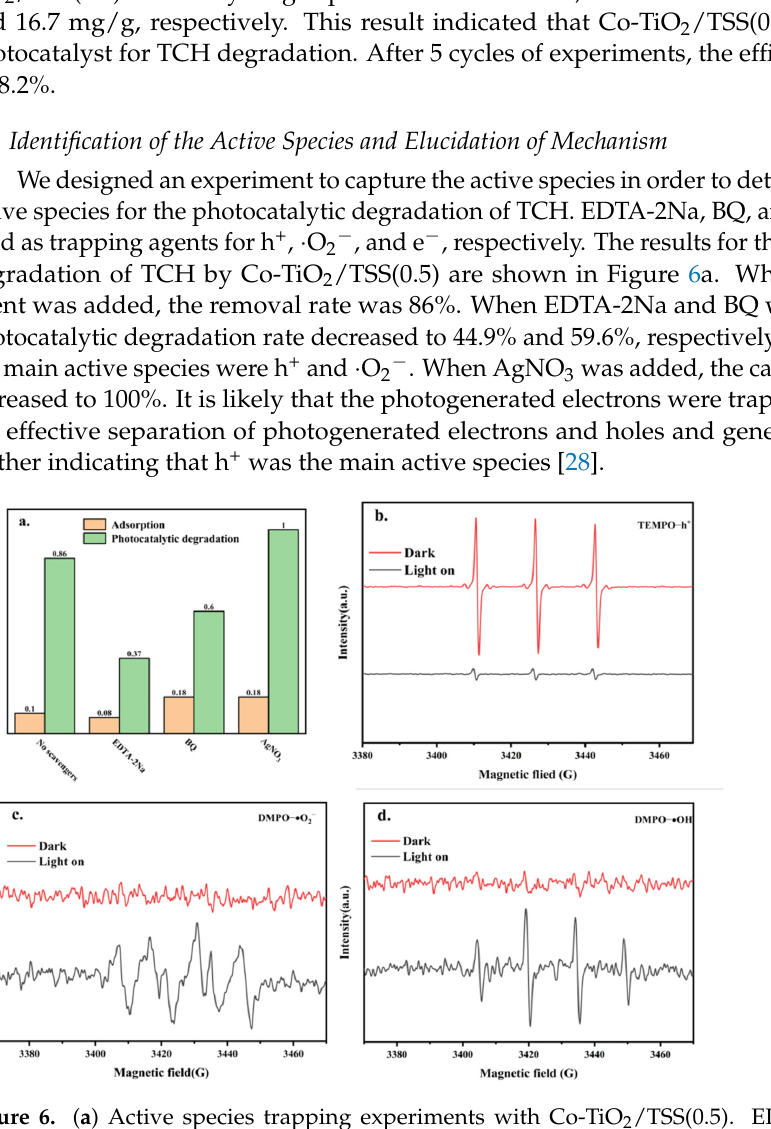
Figure 6. ( a ) Active species trapping experiments with Co-TiO 2 /TSS(0.5). EPR spectra of Co- TiO 2 /TSS(0.5) after the addition of ( b ) TEMPO to capture h + , ( c ) DMPO to capture OH, and ( d ) DMPO to capture O 2 − .